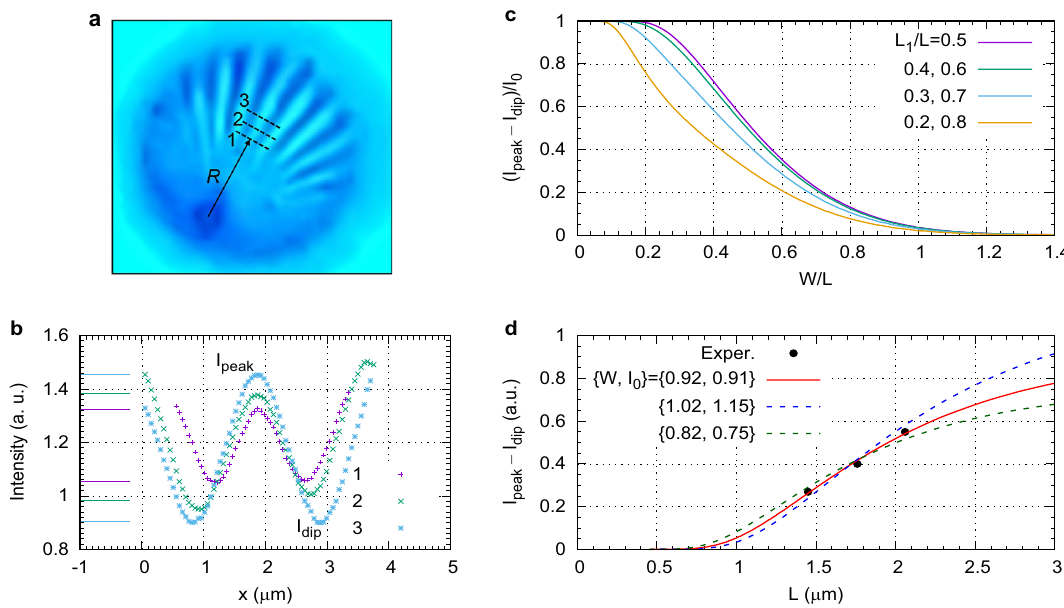
1 mm at (cid:31) =480 nm. ( a ) Image of the Figure 8. Quantification of resolution provided by a ball lens with R = Siemens star showing the cross-sections (dashed lines) along which the intensity profiles were measured. ( b ) Experimental intensity profiles (points) and estimated maximum and minimum of intensity levels (horizontal solid lines). The x scale is obtained after dividing the image coordinates by magnification. ( c ) Theoretical ( I peak I dip )/ I 0 for a periodic stripe pattern for several values of L 1 / L . ( d ) Experimental variation f ( W / L ) = − 0.6 for several sets of FWHM W and intensity I 0 . The solid points fitted with the theoretical f ( W / L ) at L 1 / L = red line shows the best fit while the two dashed lines show much worse fits for slightly different parameter